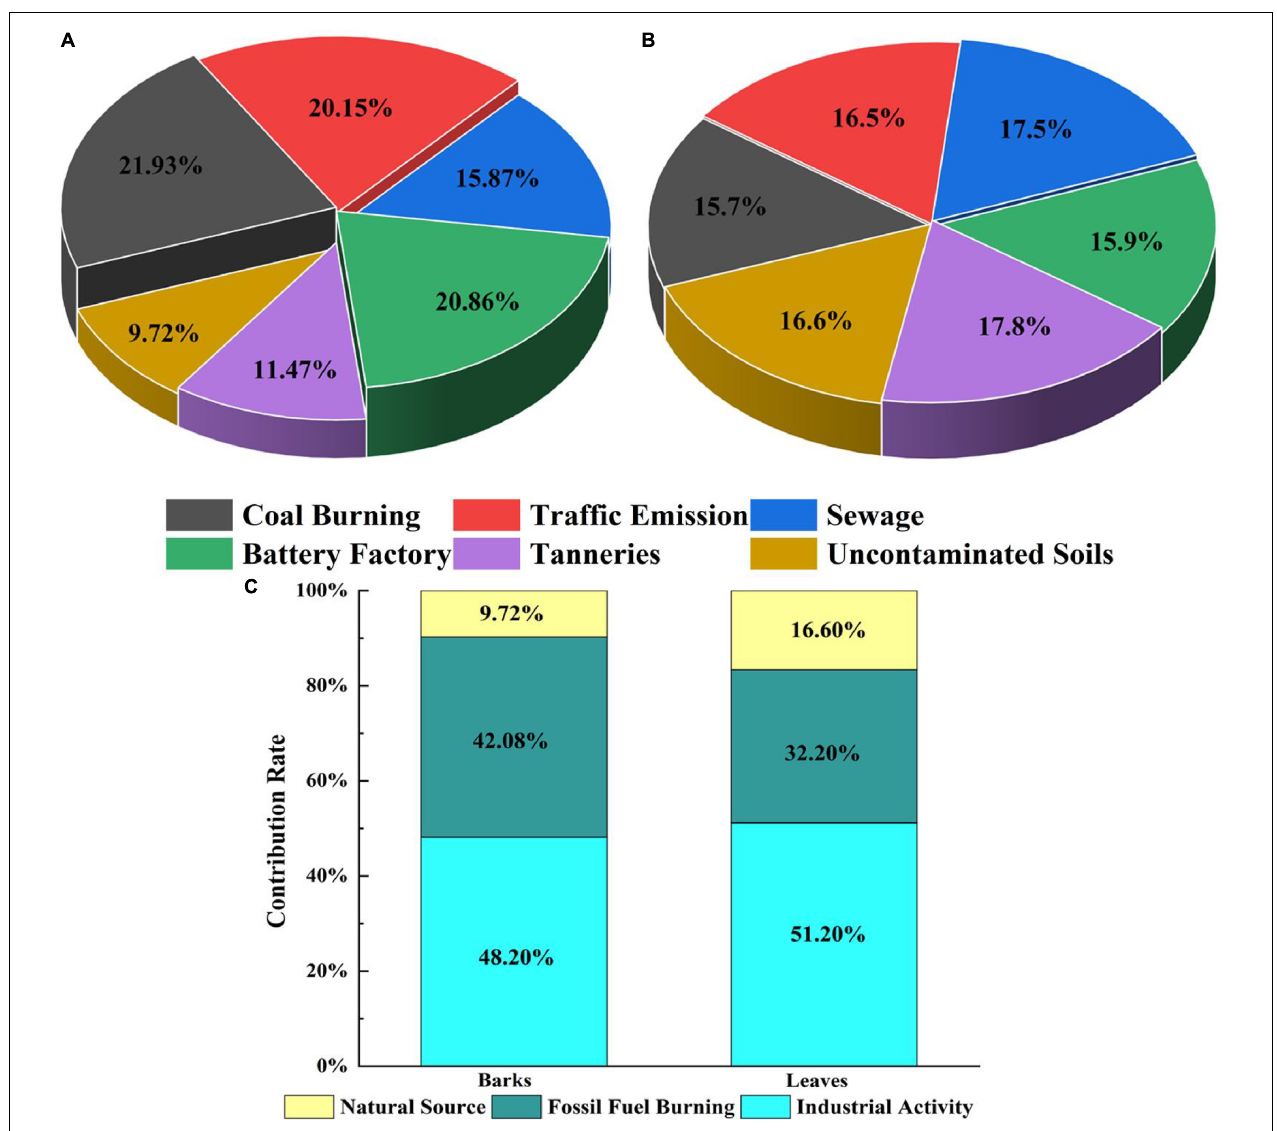
FIGURE 4 | Contribution of different pollution sources to heavy metals (HMs) in barks (A) and leaves (B) .